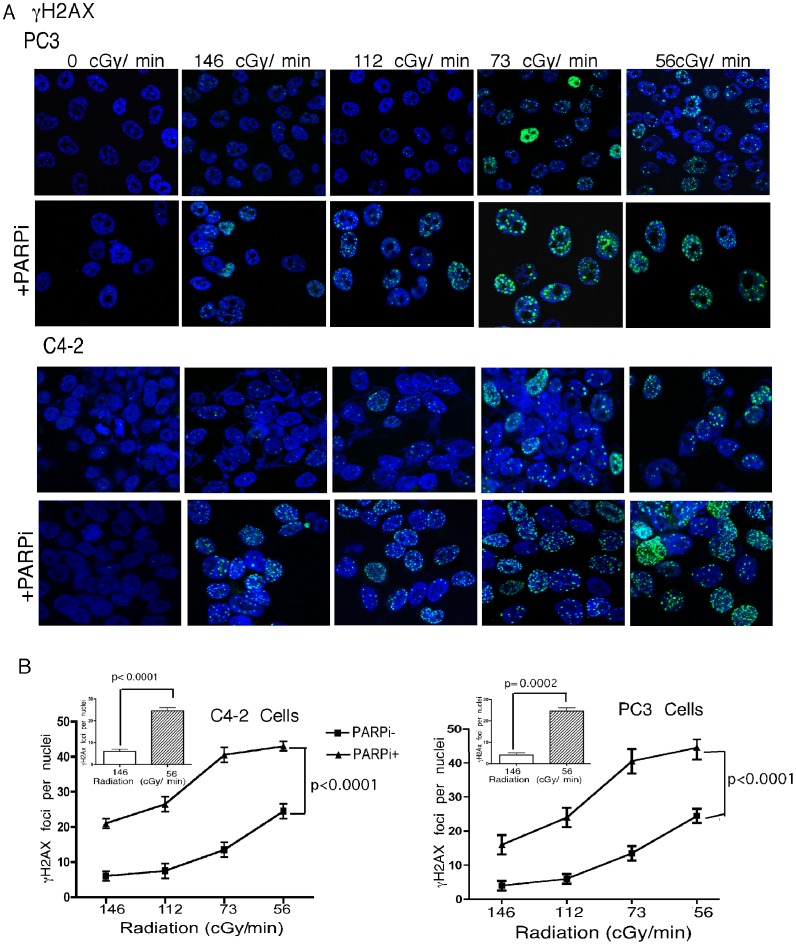
LDR induces enhanced DNA damage in the presence of rucaparib.
A, Confocal immunostaining for χH2AX foci, enumarated in PC3 and C4-2 cells following radiation at the indicated dose rates. B, Quantitation of dose-dependent formation of γH2AX foci. Error bars represent SD of mean (n = 3).